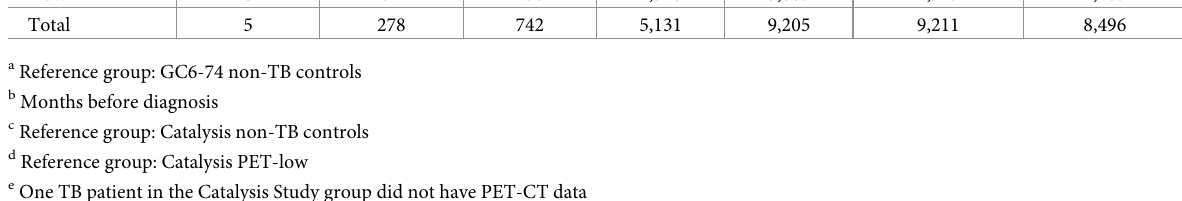
The DE results for all genes and time points are presented in S2 Table . There was substan- tial overlap in the DE genes with 92% (445/492) of the genes upregulated 7–12 months before diagnosis also being upregulated in the samples taken 1–6 months prior to TB diagnosis. Simi- larly, 85% (2,365/2,791) of the genes upregulated 1–6 months before diagnosis in GC6-74